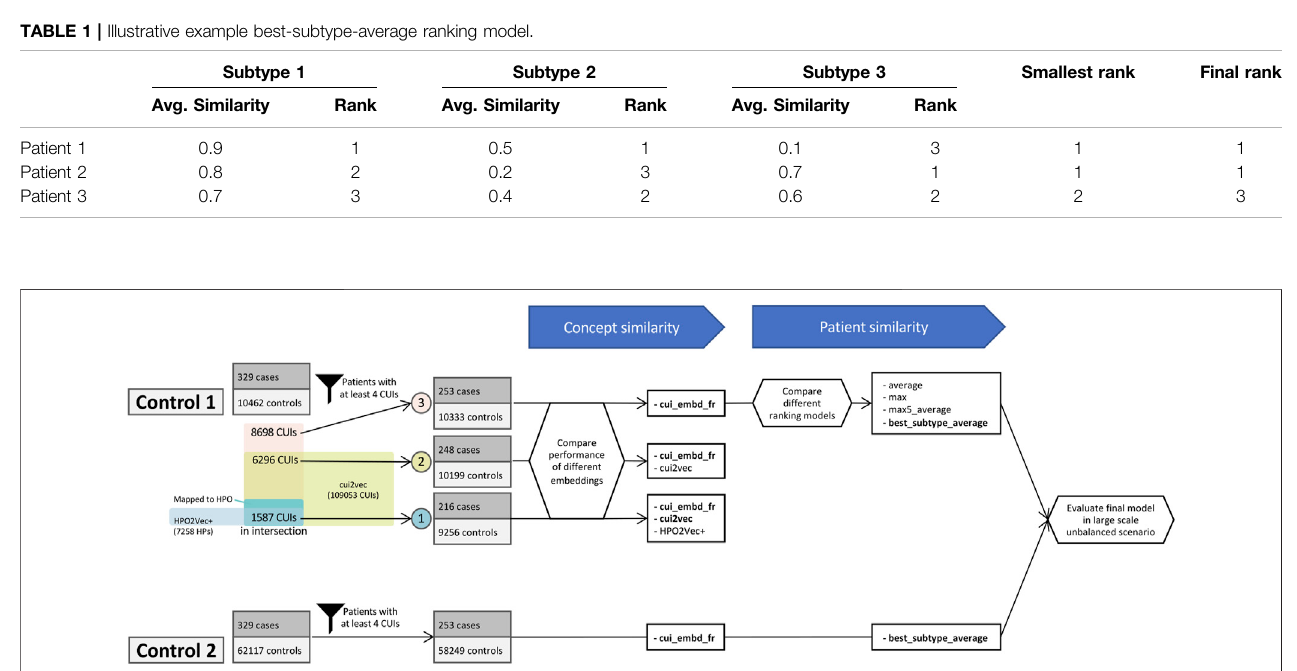
FIGURE 1 | Overarching fl ow